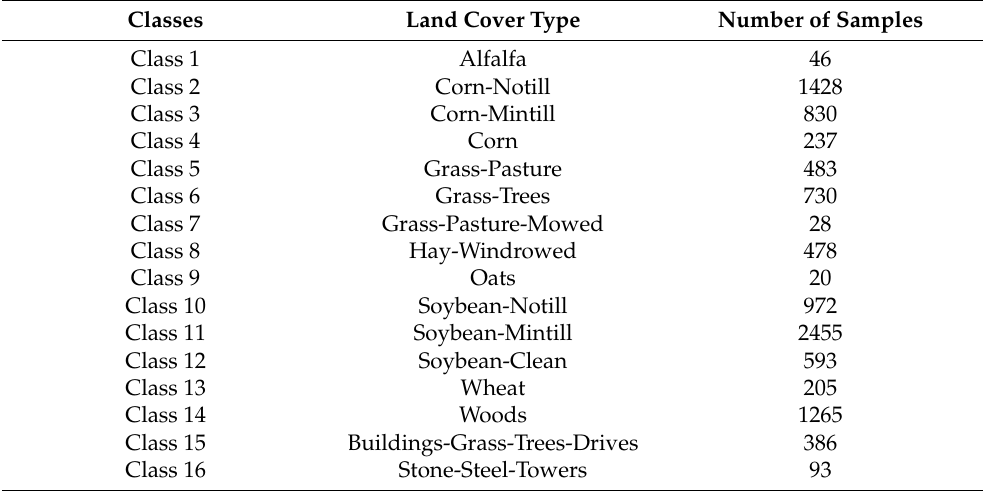
Table 1. Land cover type with the number of samples for the Indian Pines dataset.